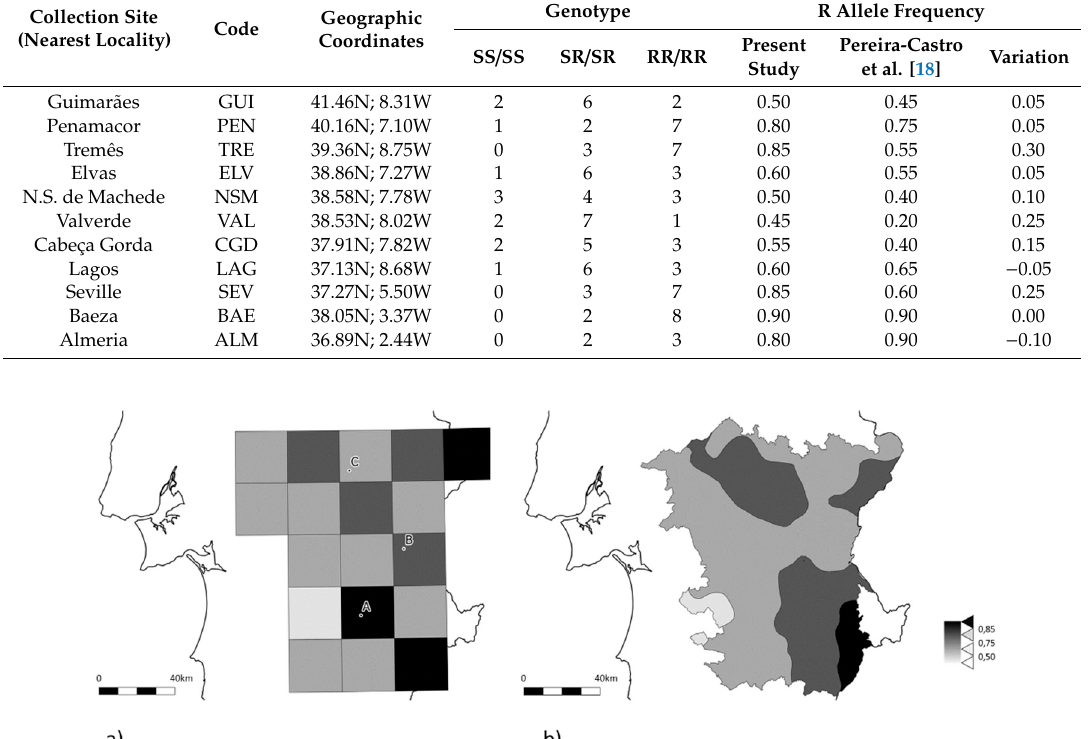
Table 1. Distributions of the I214V and G488S Bactrocera oleae Ace gene substitutions at sampling set I locations. S: Organophosphate (OP)-sensitive alleles (coding for 214I and 488G); R: OP-resistant alleles (coding for 214V and 488S). All samples were screened for ∆ 3Q.